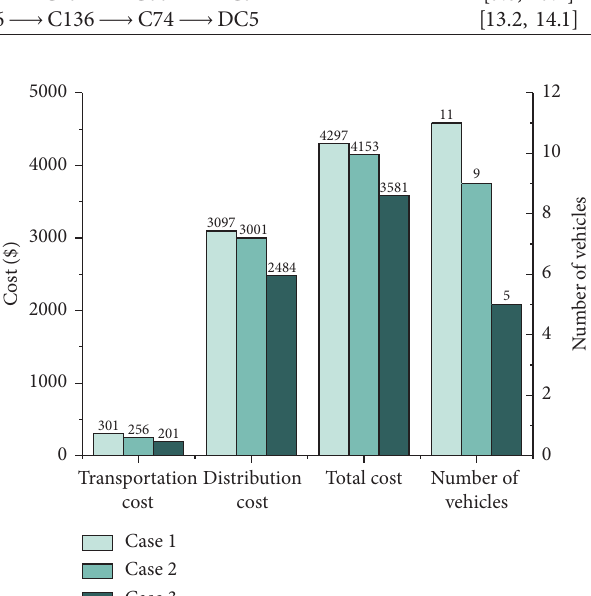
Figure 8: Result comparison before and after 2E-LRPTWTRS optimization. Figure 9: Result comparison among different vehicle-sharing